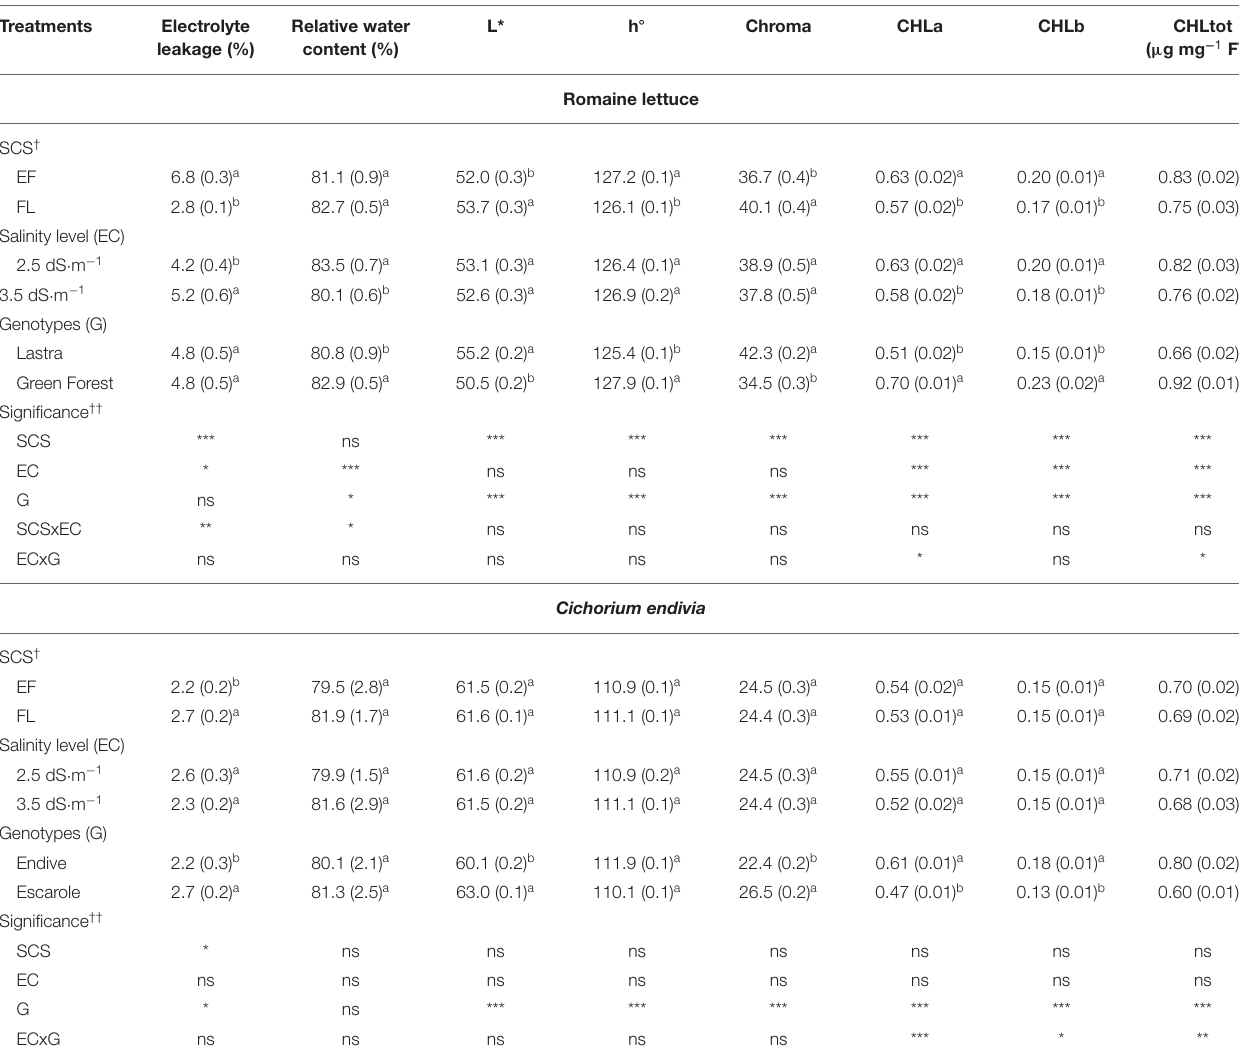
TABLE 3 | Effect of soilless cultivation system (SCS), salinity level (EC) of nutrient solution, and genotype (G) on the bio-physiological traits of romaine lettuce (autumn cycle) and C. endivia (winter cycle) leaves, with the standard error of the mean in brackets.